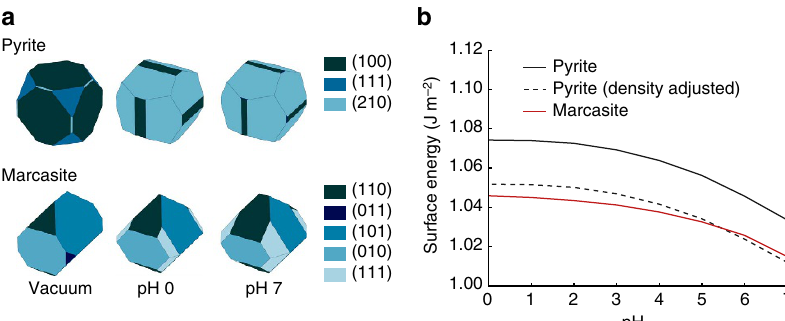
Figure 1 | Surface energies of FeS 2 pyrite and marcasite. ( a ) Equilibrium particle shapes (Wulff shapes) for pyrite and marcasite in vacuum and in solution at pH ¼ 0 and pH ¼ 7. ( b ) Surface energies of pyrite and marcasite averaged over the equilibrium Wulff shape across a range of pH levels. The solid lines give the surface energy of pyrite and marcasite per unit area, while the dashed line gives (cid:2) g p ð r m Þ 2 = 3 , the effective molar surface energy of pyrite r p scaled to account for the higher density of pyrite relative to that of marcasite. The density adjustment is necessary for a direct comparison of the effect of surface energy on stability, as it accounts for the fact that the relevant free energy for determining the relative stability of pyrite and marcasite is the molar free energy. Thus, the surface energy of a pyrite particle with an equal mole number to that of a marcasite particle must be scaled down to account for the smaller size of the denser pyrite